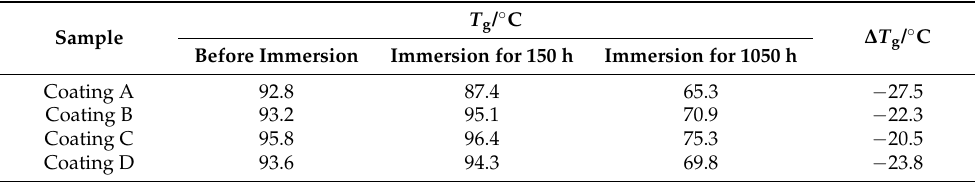
Table 3. The T g values of the coatings for samples before and after